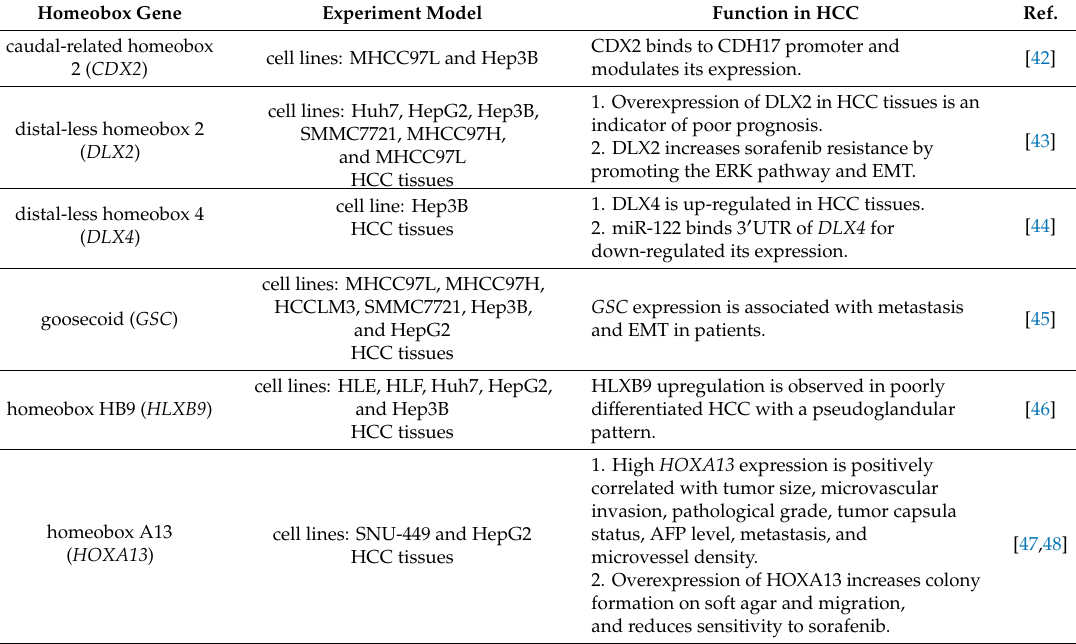
Table 2. Homeobox genes promote HCC